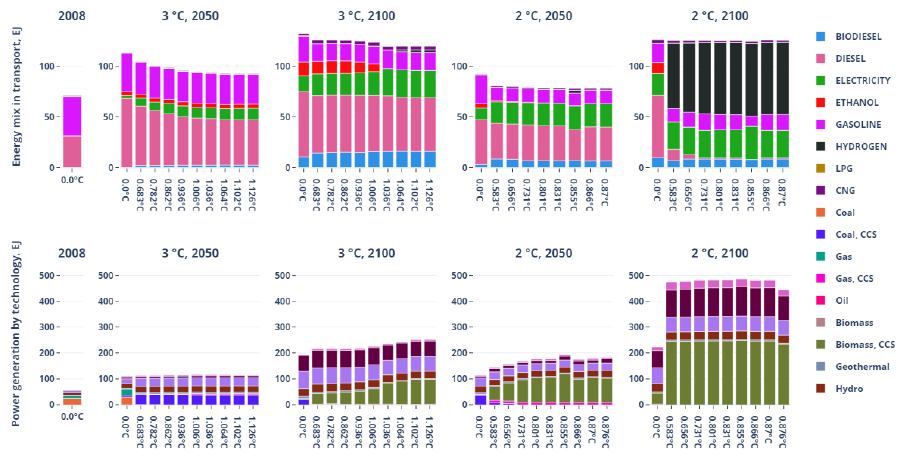
Figure 10. Energy mix for transport and electricity